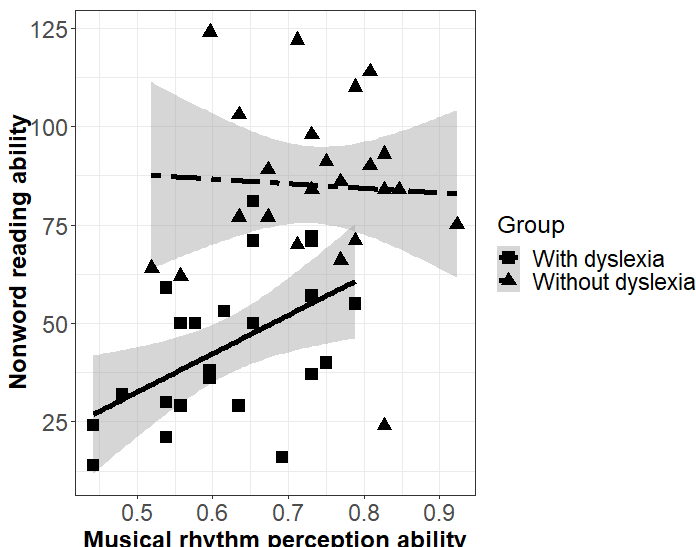
Figure 3. Linear regression lines reflecting the association between nonword reading ability (Salzburger Lese- und Rechtschreibtests (SLRT) scores) and musical rhythm perception ability (Musical Ear Test (MET) scores) split by group, shades indicate confidence intervals, rectangles (with dyslexia) and triangles (without dyslexia) the individuals’ averages.